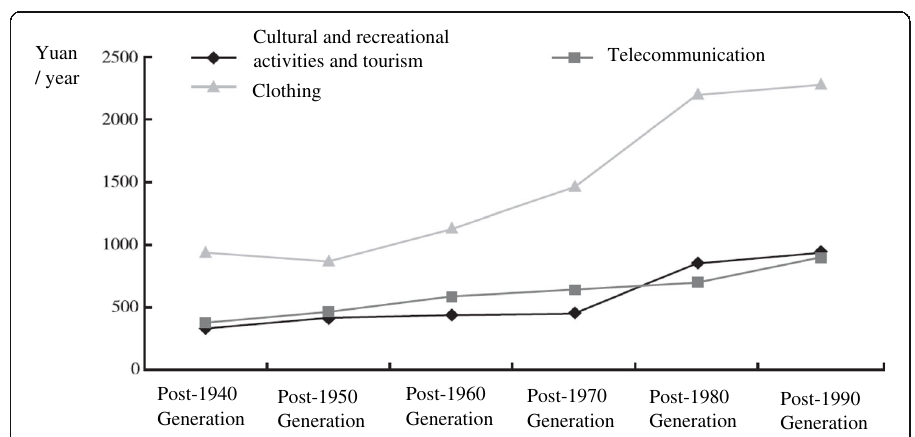
Fig. 3 Generational disparities in household expenditures (Yuan per